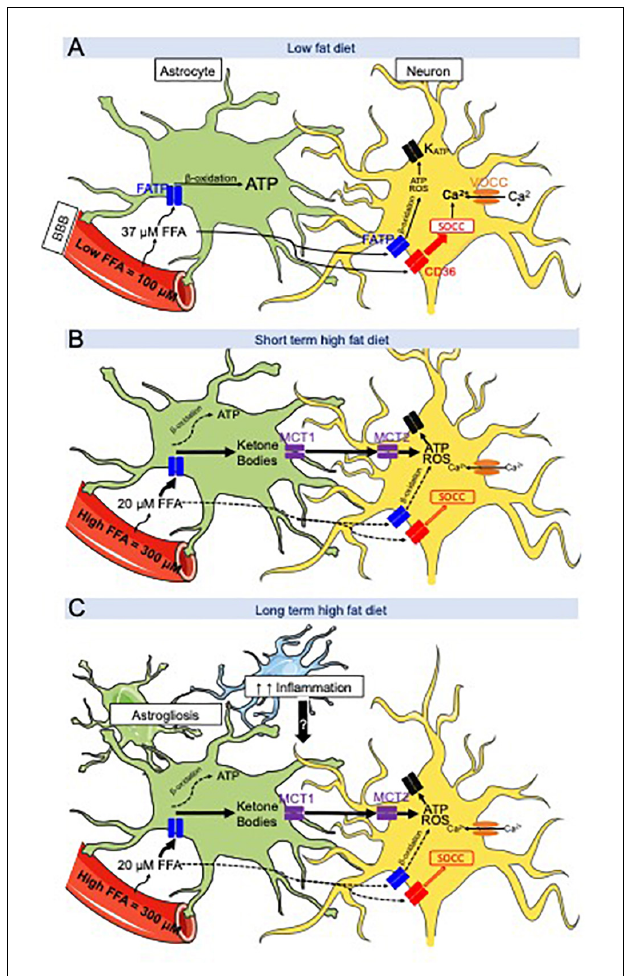
FIGURE 1 | Hypothetical working model between CD36-mediated neuronal fatty acid (FA) sensing and astrocyte-produced ketone bodies during low fat diet (LFD) and high fat diet (HFD) intake. (A) LFD intake- FA crossing the blood across the blood-brain barrier (BBB) are taken up and oxidized by astrocytes to produce ATP while FA bind to FAT/CD36 located on metabolic sensing neurons in the ventromedial hypothalamus (VMH = VMN + ARC). Their excitation or inhibition activates store-operated Ca 2 + channels (SOCC) which depolarize or hyperpolarize the neuron. (B) After a short-term HFD intake, brain extracellular FA levels are decreased compared to LFD intake due to an increase in FA flux into VMH astrocytes to generate ketone bodies. Ketone bodies are exported via MCT1 and taken up by neurons via MCT2. Ketone bodies are utilized by the neurons and produce ATP and ROS in excess. ATP and ROS are hypothesized to override CD36-mediated FA sensing which activate or inhibit the K ATP channel. (C) Long term HFD intake induces as astrogliosis and microglial inflammation. These cytokines might interfere with the astrocyte-neuronal communication leading to disturbances in the control of food intake promoting continued hyperphagia on HFD. Adapted from Le Foll and Levin